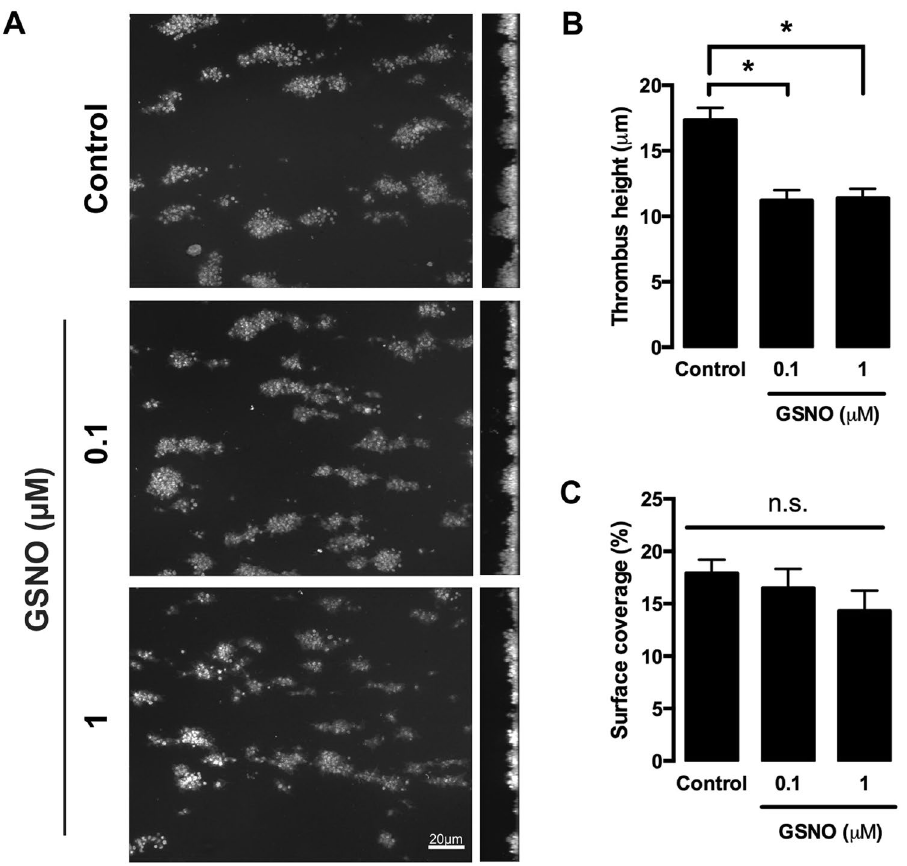
Figure 6. Perfusion of NO over preformed thrombi on collagen under shear stress reduces thrombus height. Whole human blood anticoagulated with PPACK (10 µ M) and labelled with DiOC 6 (10 µ M) was flowed over collagen-coated slides (25 µ g/ml) for 2 minutes at 1000 s − 1 to allow platelets to adhere spread and form small aggregates. Aggregates and spread platelets were then perfused with either buffer (control) or GSNO (100 nM or 1 μ M) for a further 20 minutes. Platelets were fixed with 4% paraformaldehyde for 30 minutes followed by further DiOC 6 staining. Images were acquired via the Zeiss Axioobserver confocal microscope at x63 magnification. Percentage area coverage was analysed using ImageJ. ( A ) Representative images of thrombi perfused with buffer (control) or GSNO in the x-y plane (left panels) and z-x plane (right panels) for 20 minutes. ( B ) Quantification of thrombus height ( C ) Quantification of area coverage. Data represents 3 repeats. Error bars represent S.E.M. with significance ( * ) defined as p < 0.05. Scale bar is representative of 5 μ